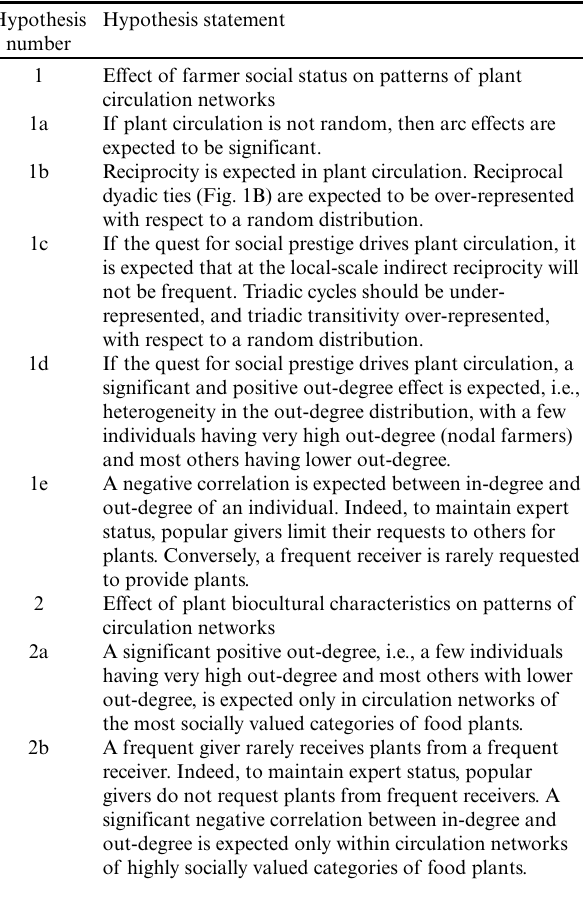
Table 1. List of hypotheses and subhypotheses assessed. Hypothesis Hypothesis number